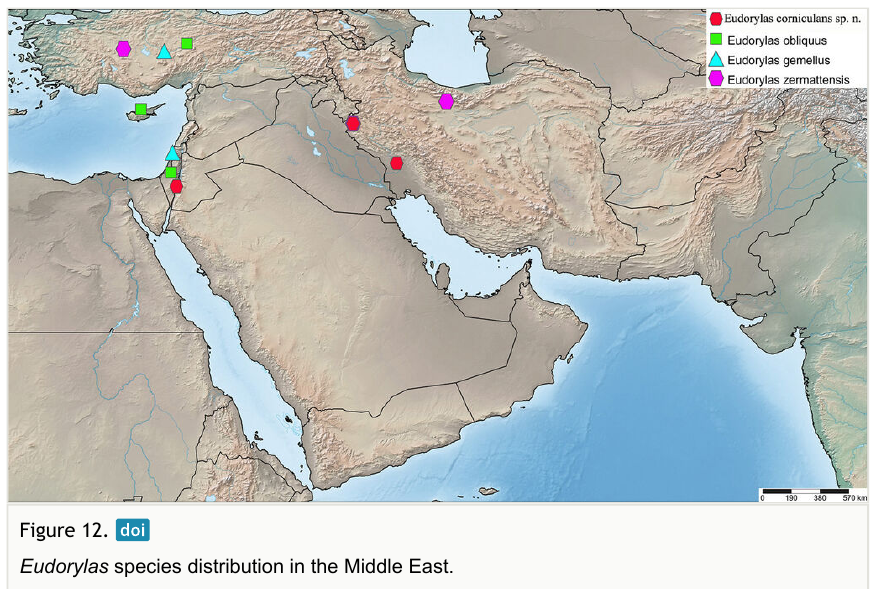
Figure 12. Eudorylas species distribution in the Middle